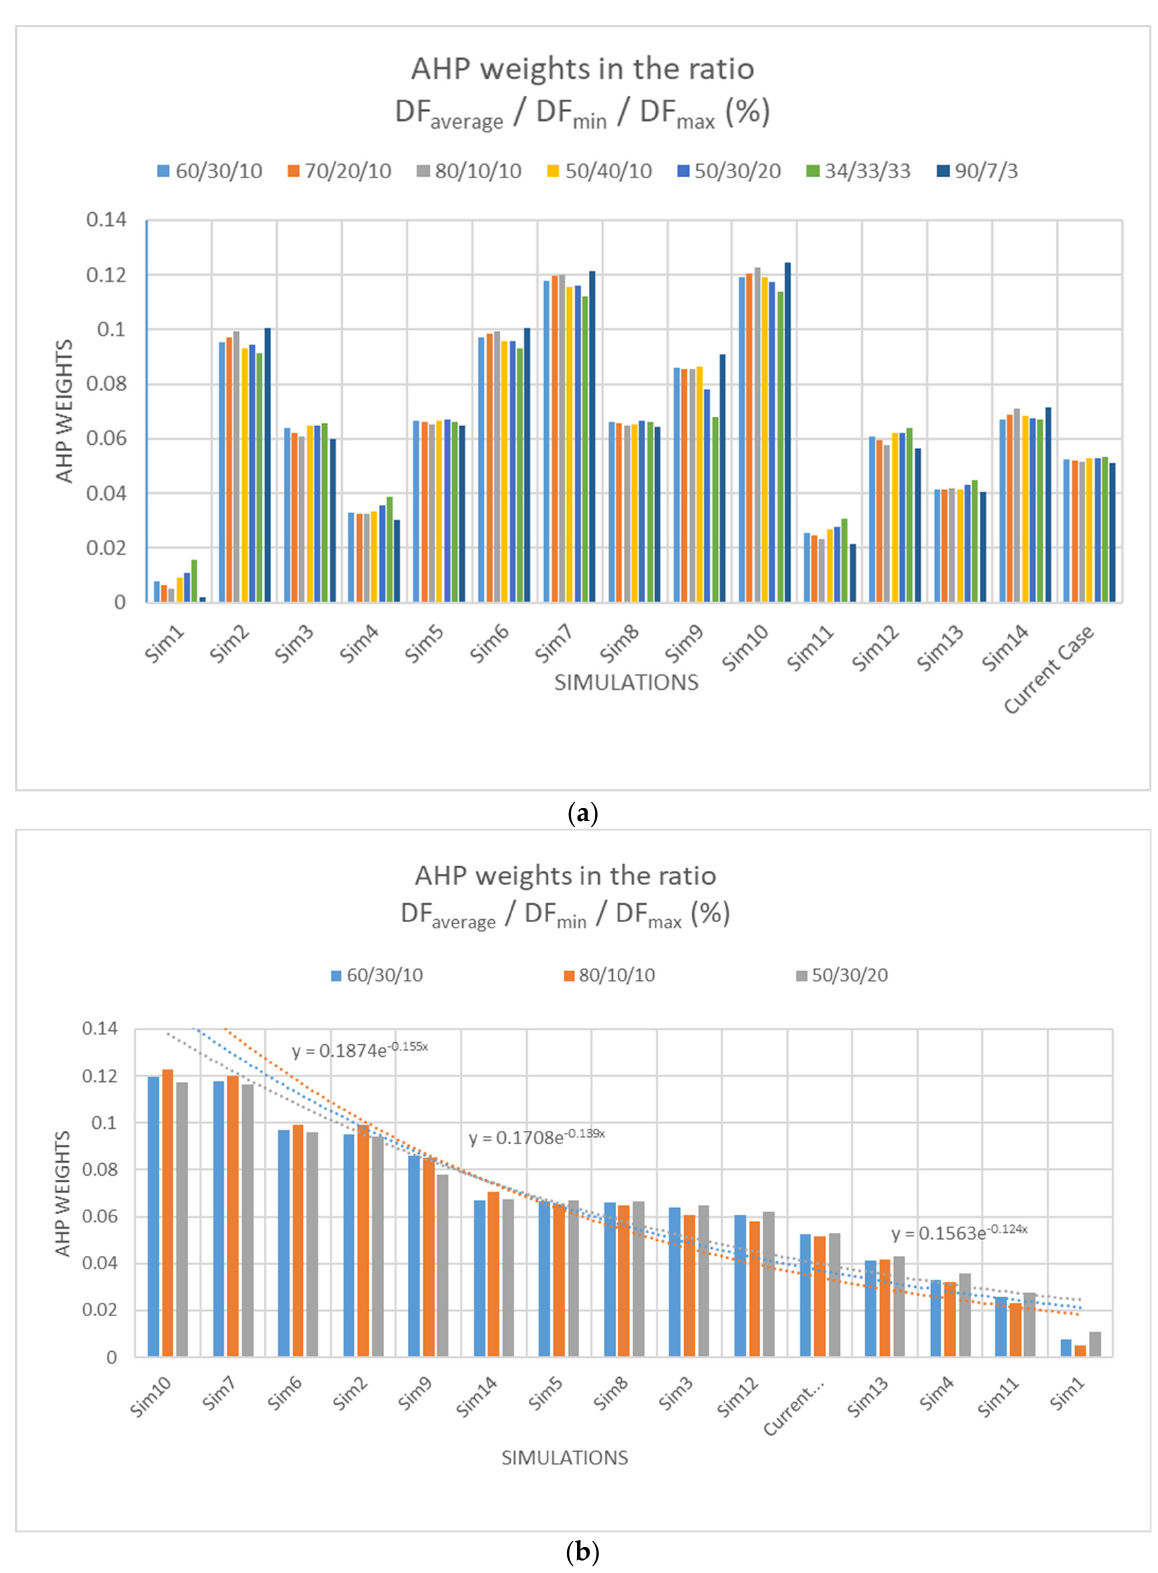
Figure 9. ( a ) AHP for 7 selected alternatives. ( b ) AHP for three variants of DF ratios according to importance.